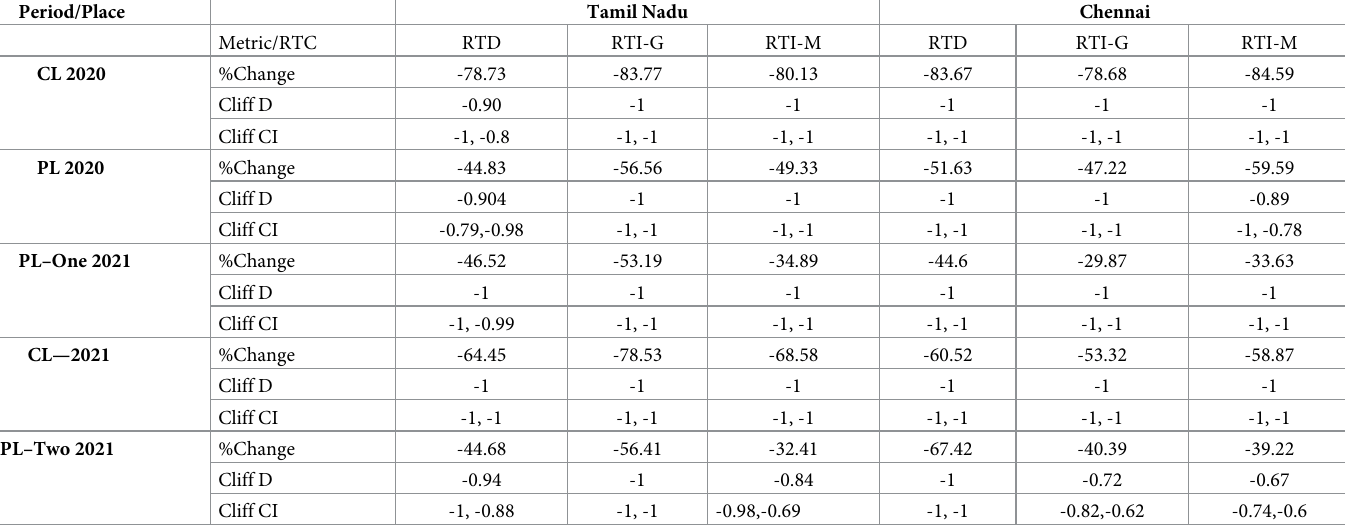
Table 7. Percentage changes in mean and effect size (Cliff s Delta) of TN and Chennai.